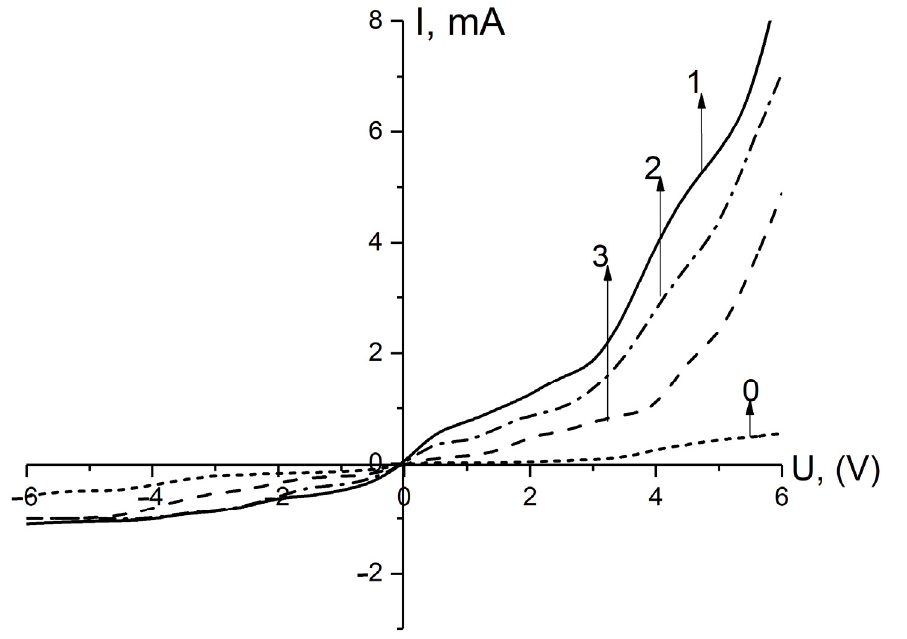
Figure 6. CVC of ZnSeO 3 after CD: 0—SiO 2 /Si; 1—after 15 min of deposition; 2—after 20 min; 3—after 25 min.